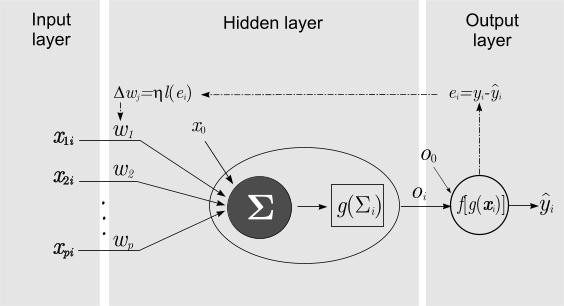
Pictorial representation of a neural network (multilayer perceptron) with input layer (dendrites), hidden layer (nucleus) and output layer (axon) (see text for a description of the neural networks components).